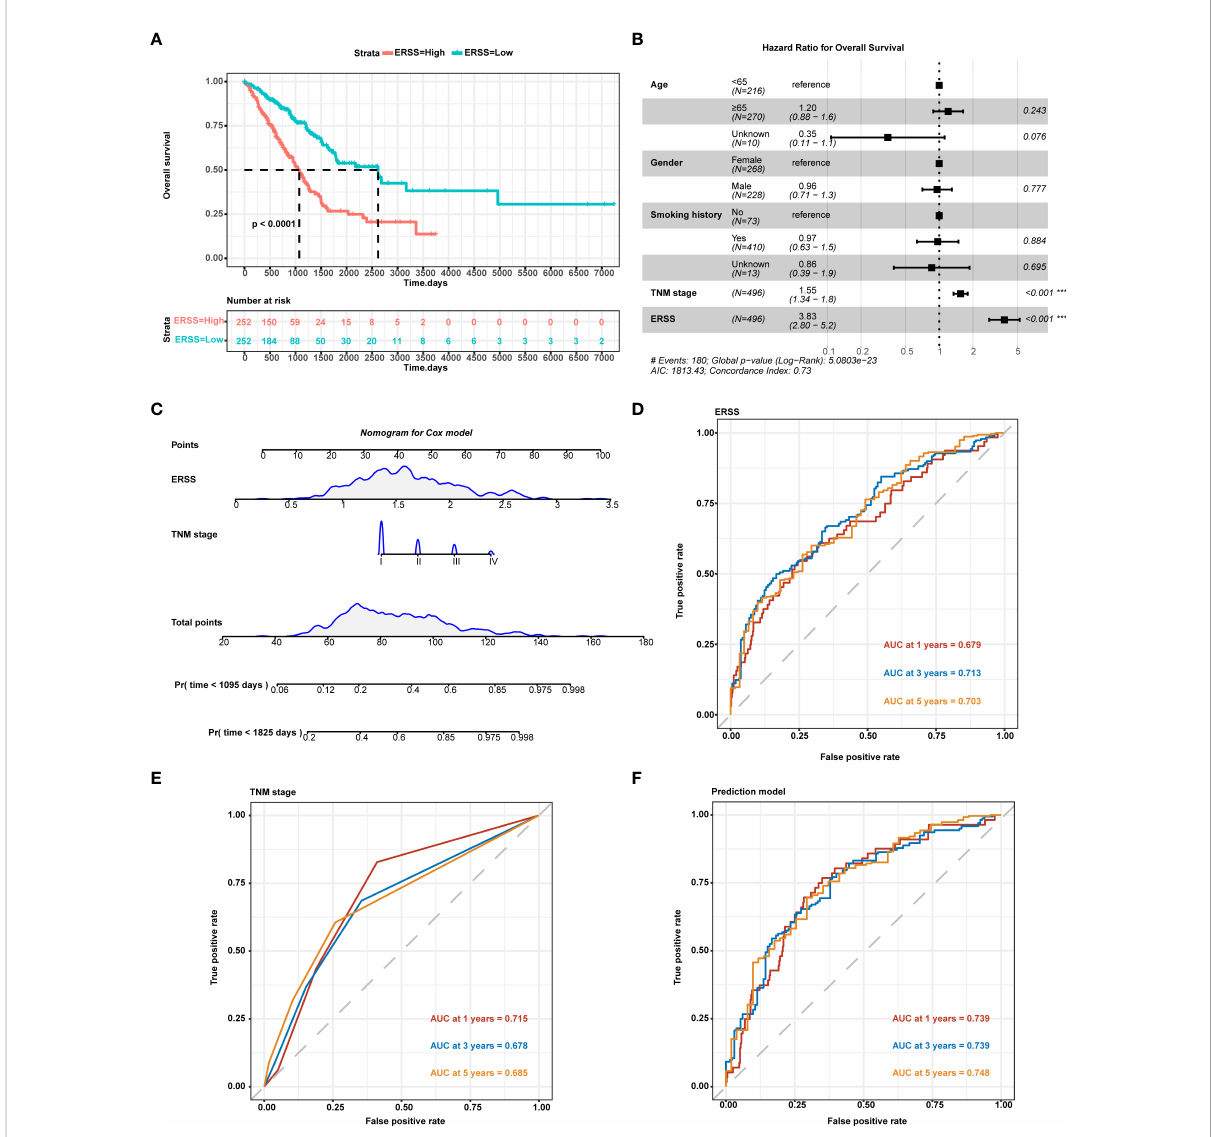
FIGURE 2 Constructing ERSS to predict OS in LUAD patients from TCGA cohort. (A) Patients with high ERSS showed signi fi cantly shorter OS ( p < 0.0001). (B) Cox regression analysis showed that higher TNM stage ( p < 0.001, HR = 1.55, 95%CI: 1.34 – 1.8) and higher ERSS ( p < 0.001, HR = 3.83, 95%CI: 2.8 – 5.2) were independent predictors for shorter OS. (C) We constructed a prediction model consisting of the TNM stage and ERSS by Cox regression. Nomogram was used to visualize the Cox model. (D) AUC at 1, 3, and 5 years of ERSS for OS. (E) AUC at 1, 3, and 5 years of TNM stage for OS. (F) AUC at 1, 3, and 5 years of the prediction model for OS. ERSS, endoplasmic reticulum stress score; LUAD, lung adenocarcinoma; TCGA, The Cancer Genome Atlas; OS, overall survival; ROC, receiver operating characteristic; AUC, the area under curve. *** p